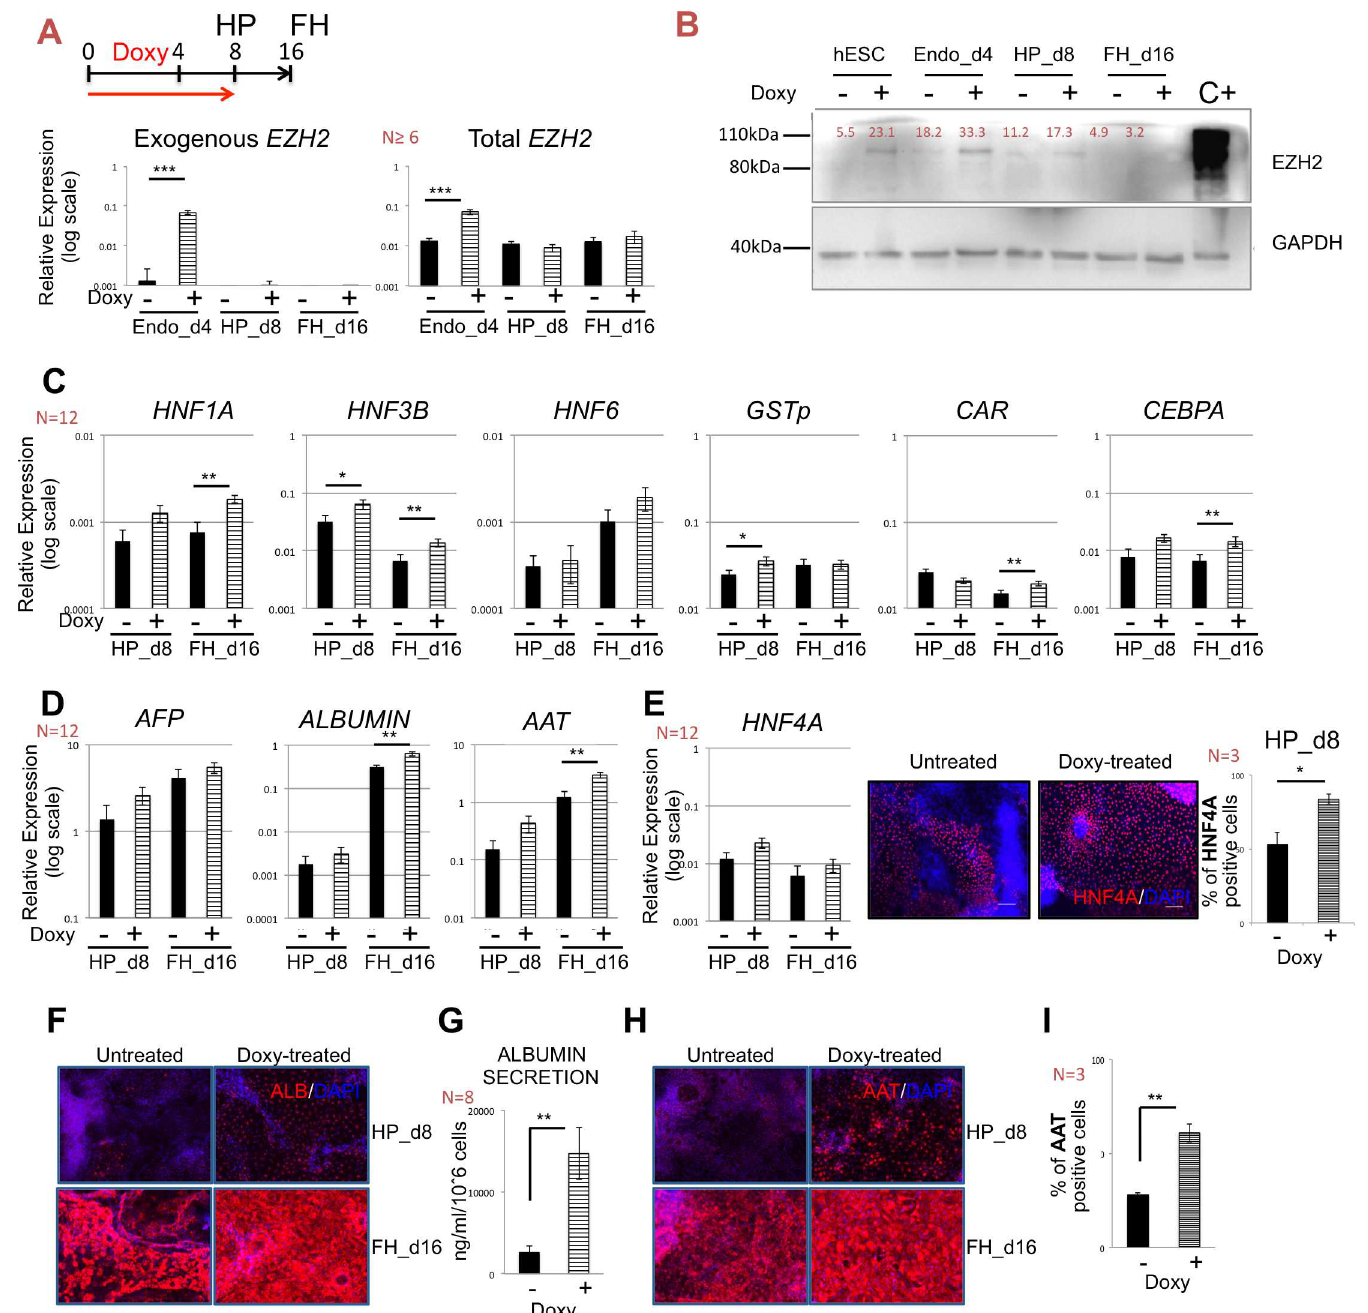
Fig 3. EZH2 regulation and fetal hepatocytes differentiation. A. Upper part, directed differentiation of hPCS- i EZH2 toward fetal hepatocytes(FH_d16) with additionof 5 μ g/mldoxycycline(doxy) in the first 8 days of differentiation (red arrow). Bottom part, relative gene expressionof the EZH2 transgene (Exogenous EZH2 ) and both endogenousand exogenous EZH2 (Total EZH2 ) at endo_d4,HP_d8 and FH_d16 in untreated (-) and EZH2 doxy inducedcells (+). Relativegene expression to GAPDH and same scale bar. Data as mean ± SEM of n (cid:21) 3 IEs. B. Western blot for EZH2 and GAPDH in untreated (-) and EZH2 doxy inducedcells (+) at hPSC, endo_d4,HP_d8and FH_d16. Positive control: HEK293T cells transiently transfected with pLVX-IRES-Hygro- hEZH2. The molecularweight size marker was croppedfrom the gel. Signals were quantifiedand indicatedas % to loadingcontrol. C. Relativeexpression (to GAPDH )of hepaticmarkers HNF1A , HNF3B , HNF6 , GSTp and transcription factors CAR and CEBPA in HP_d8and FH_d16untreated (-) andEZH2 doxy inducedcells (+). Data as mean ± SEM of n (cid:21) 3 IEs. * p < 0.05 and ** p < 0.01. D. Relativegeneexpression (to GAPDH ) of hepatic marker genes AFP , ALBUMIN andAAT in HP_d8andFH_d16untreated(-) and EZH2 doxy inducedcells (+). Data as mean ± SEM of n (cid:21) 3 IEs. * p < 0.05, ** p < 0.01. E. Left part, relative geneexpression (to GAPDH ) of hepatictranscriptionfactor HNF4A in HP_d8and FH_d16untreated(-) and EZH2 doxy inducedcells (+). Right part, representative immunofluorescence imagesfor HNF4A (red signal)on day 8 for cells treated without(untreated)or with doxy (doxy-treated). Nucleiare